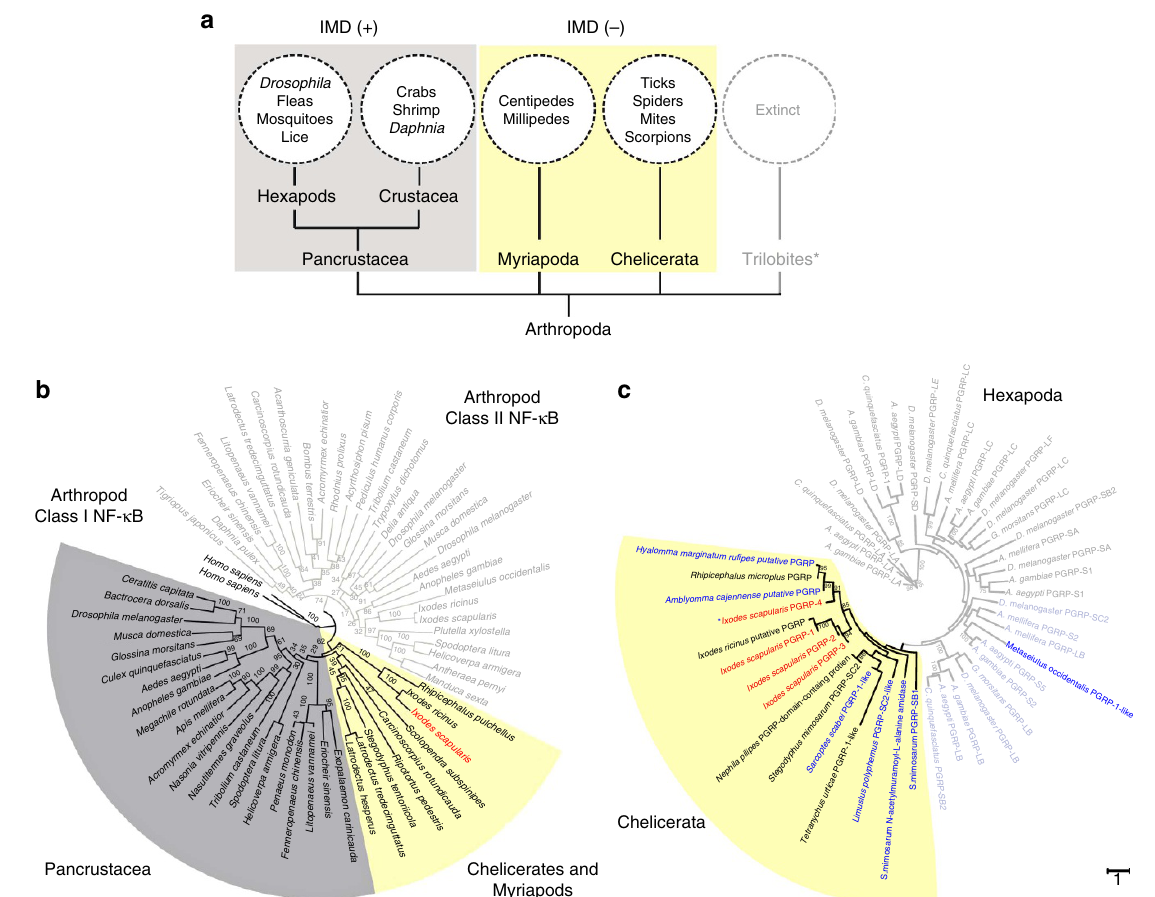
Figure 7 | The atypical IMD pathway in Chelicerates/Myriapods. ( a ) BLASTwas used to survey arthropod sequences. The Drosophila IMD was used as a query sequence. Confounding factors, such as sparsely populated data matrices, sequence misalignment and biased statistical confidence were removed. *Trilobites are an extinct subphylum. ( b ) The Rel homology domain sequence from D. melanogaster Relish was used to search arthropod transcripts for relish (class I) and other Rel domain-containing targets ( dorsal and dif ; class II) with tBLASTn. Two human NF- k B molecules served as outgroups. ( c ) I. scapularis PGRP sequences include PGRP-1: XM_002411731.1, PGRP-2: XM_002433644.1, PGRP-3: XM_002410377.1 and PGRP-4: XM_002413046.1. PGRP-1 was used to search chelicerate proteomes for PGRPs. Bootstrap values greater than or equal to 70 are shown. Yellow shading indicates chelicerate PGRP sequences, with I. scapularis PGRPs highlighted in red. Insect PGRPs are coloured gray and light blue. Blue labels and asterisks denote probable amidase activity based on the residues HHC in the active site. ( b , c ) MUSCLE was used to generate the multiple sequence alignment. The maximum likelihood phylogenetic tree was calculated with RAxML and re-sampled 100 times to assess clade support. See also Supplementary Figs 6 and